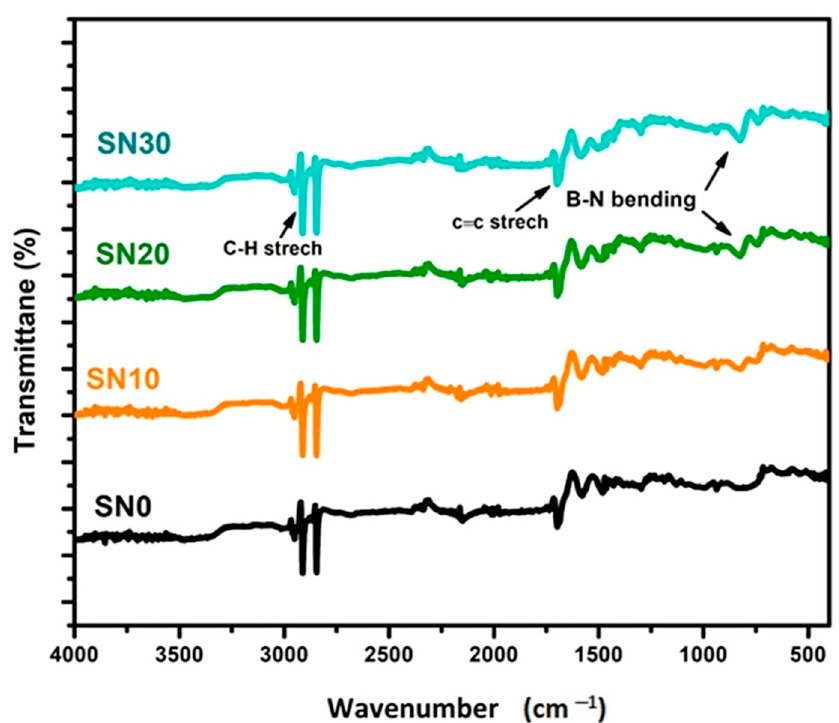
Figure 5. FTIR of pristine PS and PS/m-BN composites, as SN10, SN20 and SN30.